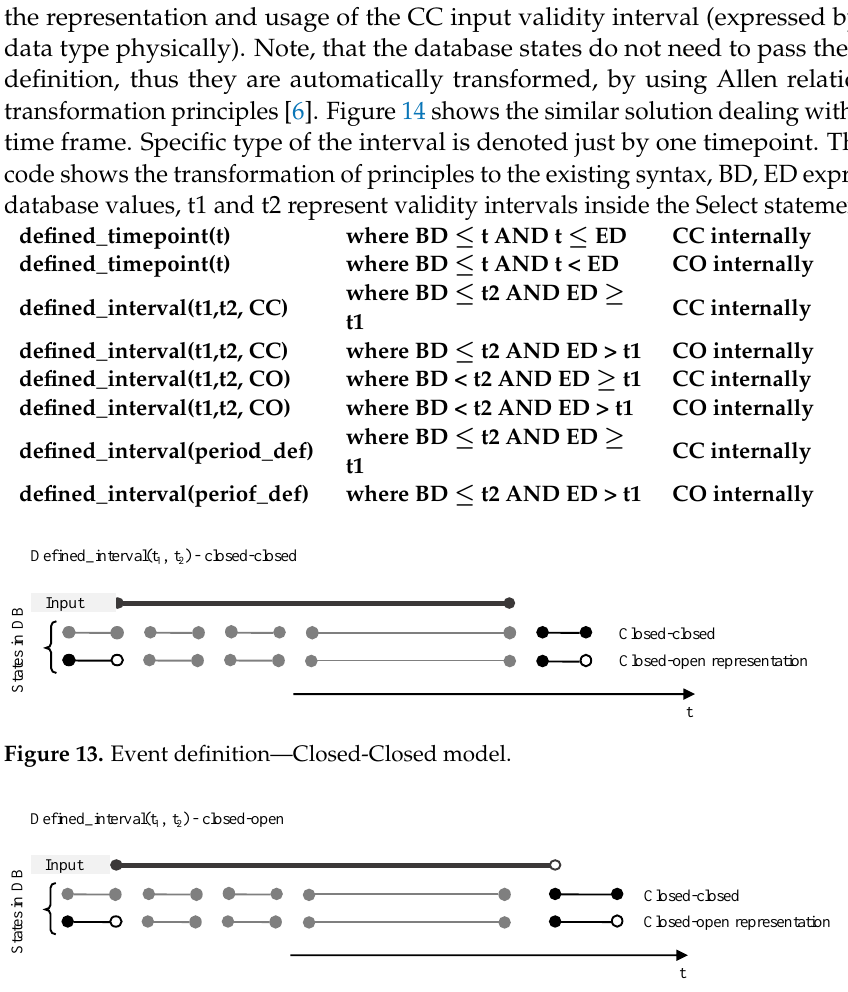
Figure 14. Event_definition—Closed-Open model.